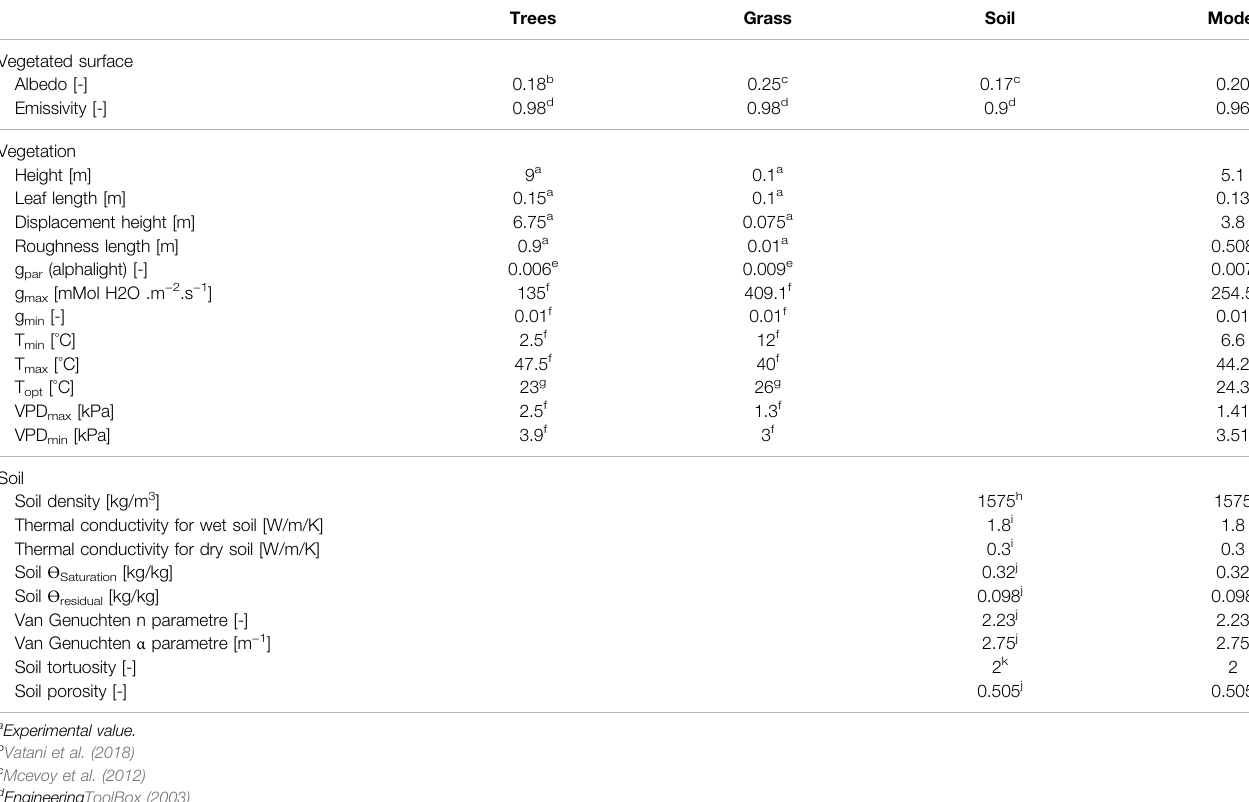
TABLE 3 | Parameters for trees, grass and soil, and fi nal parameters retained for model